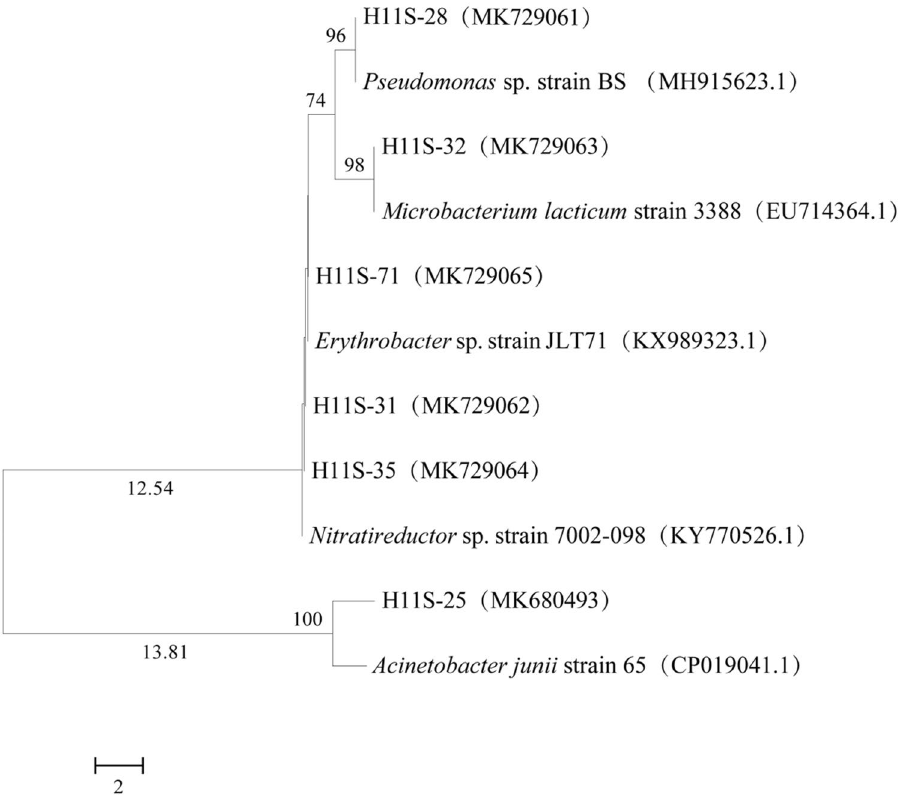
Figure 5. Phylogenetic tree of the oil-degrading strains isolated from the deep-sea sediment samples based on 16S rRNA gene sequences.